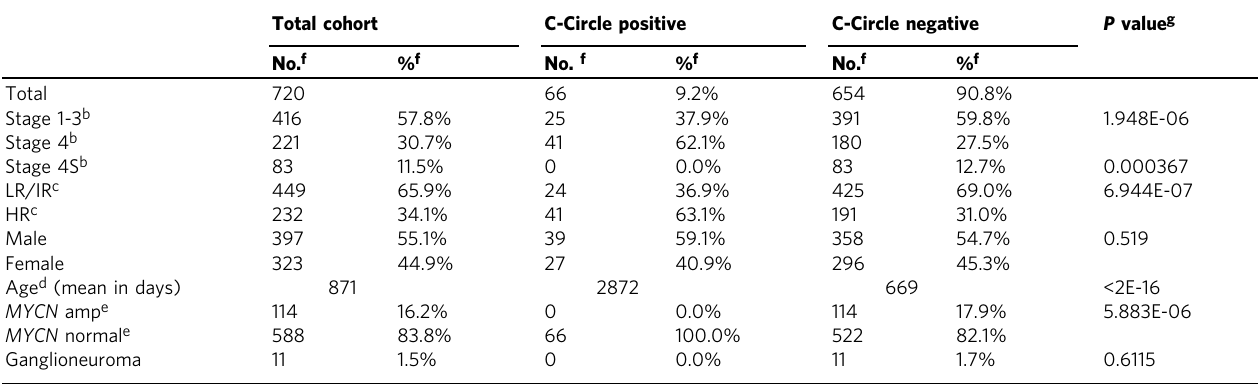
Table 1 Clinical features of C-Circle positive tumors in the screening cohort ( n = 720) a .